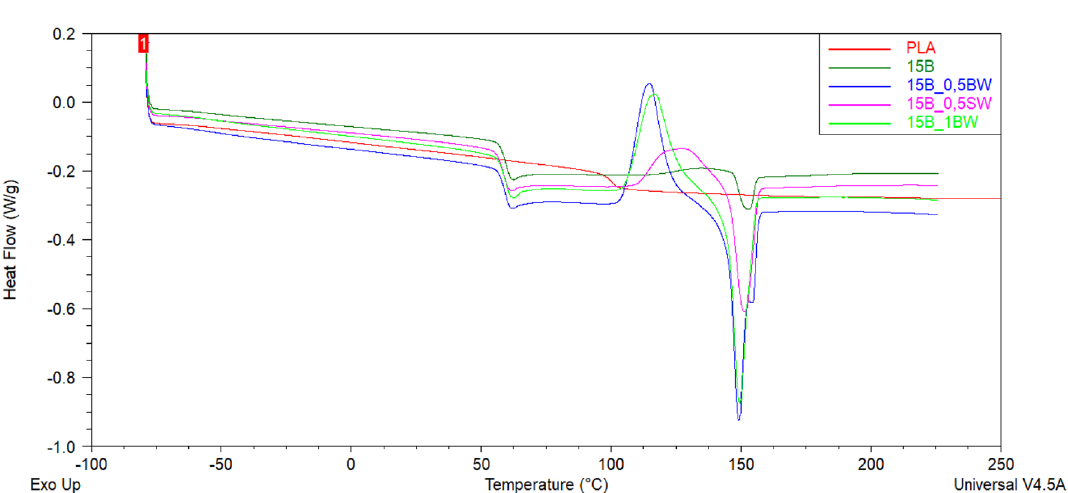
Figure 11. DSC curves of unmodified PLA and 15% DE composites with different type and loading of waxes obtained during second heating cycle.